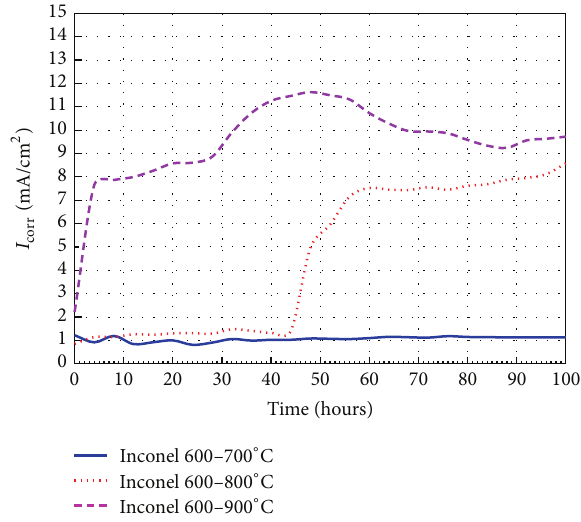
Figure 3: Current density ( 𝐼 NaCl-KCl at different